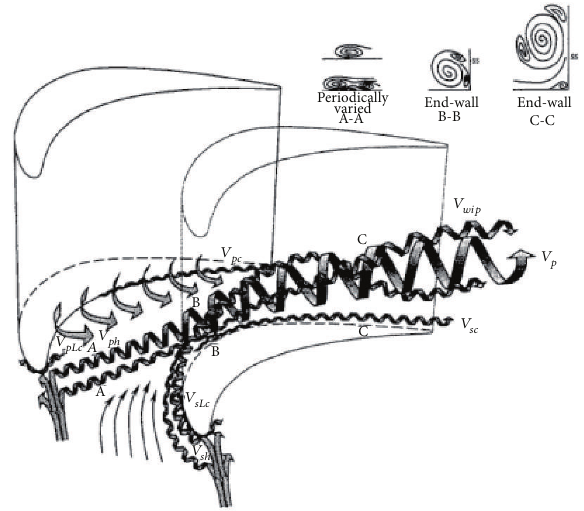
Figure 1: Secondary flow model by Wang et al.